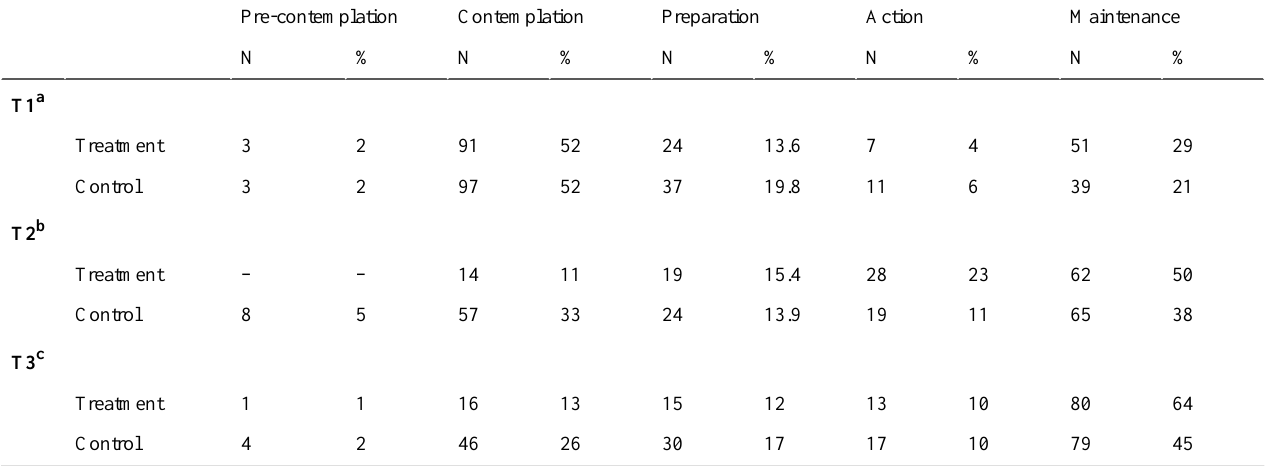
Table 2. Stages of change groups by condition at T1, T2, and